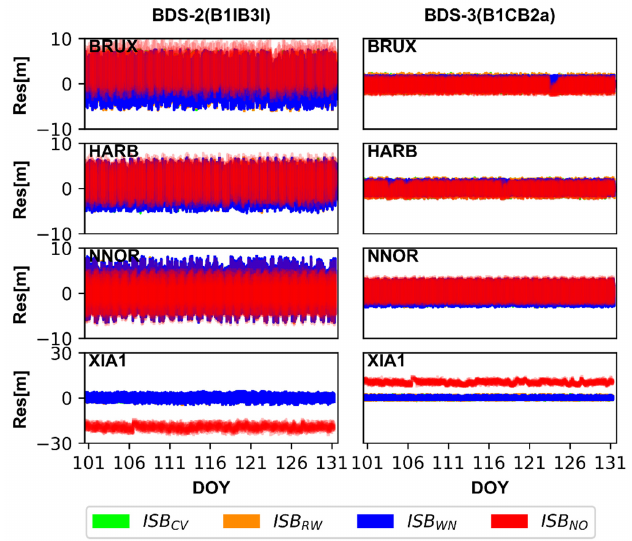
Figure 10. The IF pseudo-range observation residuals of BDS-2 (B1I/B3I) and BDS-3 (B1C/B2a) satellites for four ISB stochastic models based on GFZ products. Table 5. The mean and STDs of observation residuals of BDS-2 (B1I/B3I) and BDS-3 (B1I/B3I) satel- lites for four ISB stochastic models based on GFZ products. BDS-2 (B1I/B3I) BDS-3 (B1I/B3I) Items Station ISB NO ISB CV ISB RW ISB WN ISB NO ISB CV ISB RW ISB WN